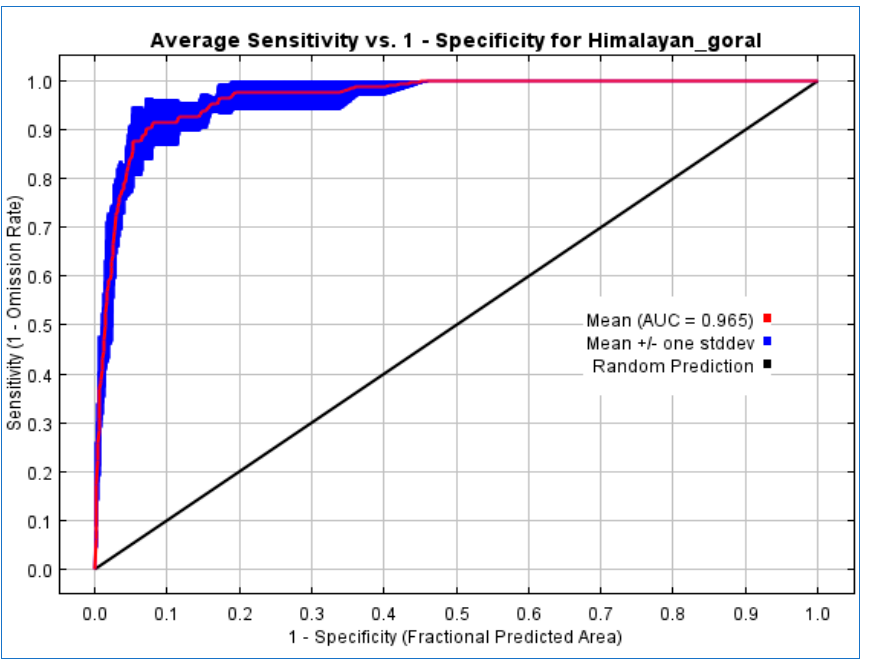
Figure 3. Graph depicting AUC-ROC value of the current climate (1970s–2000s) MaxEnt model. The model’s precision was 0.965.